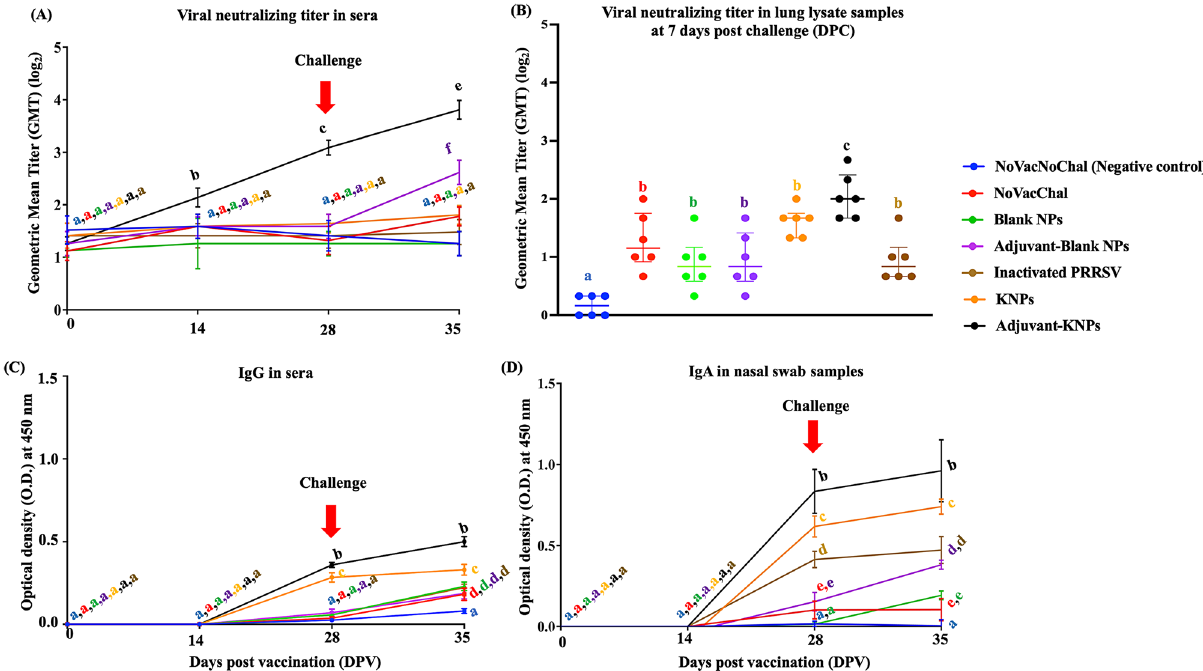
Figure 6. Humoral immune responses in experimental pigs. Analyses were performed to determine ( A ) virus neutralizing titer (VNT) in sera, ( B ) VNT in lung lysate samples, ( C ) anti-PRRSV IgG antibody response in sera, and ( D ) anti-PRRSV IgA antibody response in nasal swab samples. The data represent the mean ± SEM. Different lowercase letters indicate significant differences between groups ( p <